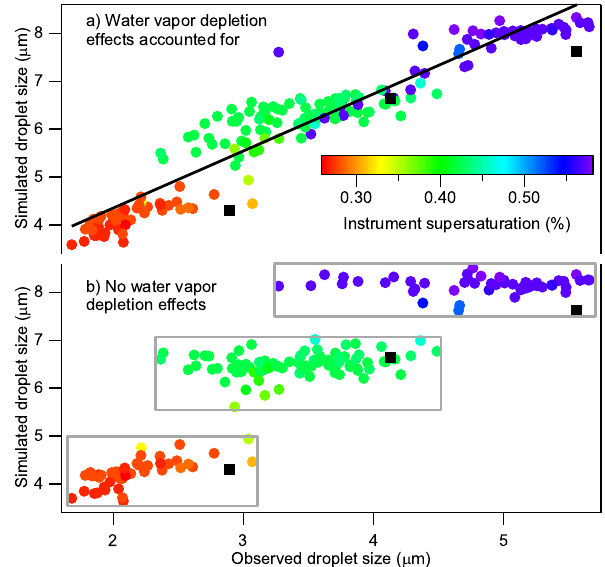
Fig. 10. Simulated droplet size as a function of observed droplet size. Simulations in the upper plot account for water vapor depletion effects, but these are ignored in the simulations shown in the lower plot. The marker color is based on instrument supersaturation. The black square markers represent average data from the calibration experiments and simulations. The gray boxes show the approximate extent of observed and predicted (without water vapor depletion) droplet size variability for the three common